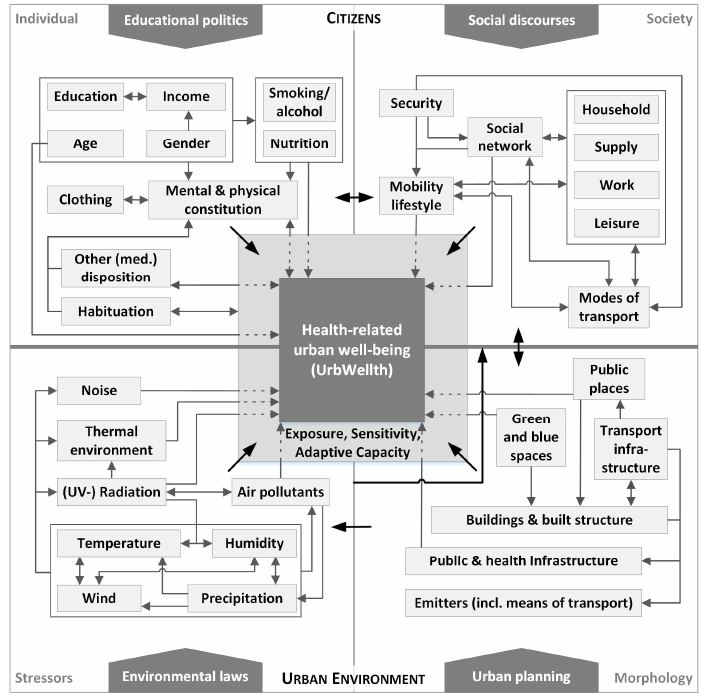
Figure 1. Conceptual model of health-related urban well-being (UrbWellth) [4].